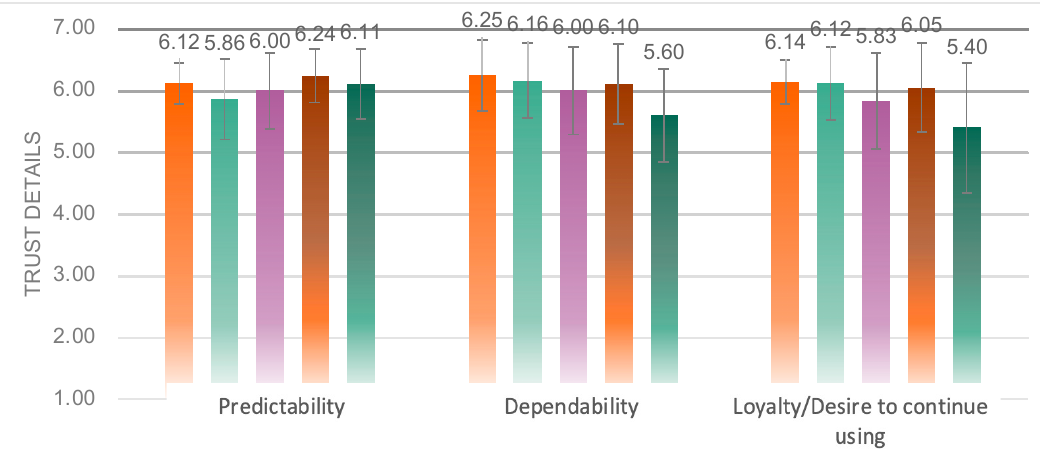
Figure 17. Detail values of the DALI scale of the five groups.